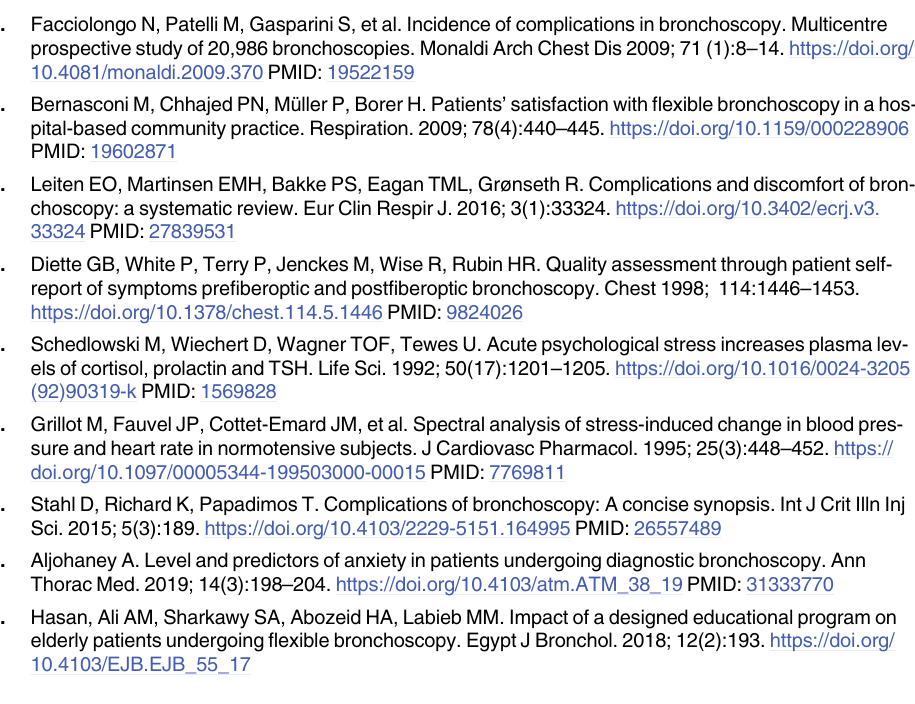
S2 Fig. Comorbidities in population of the